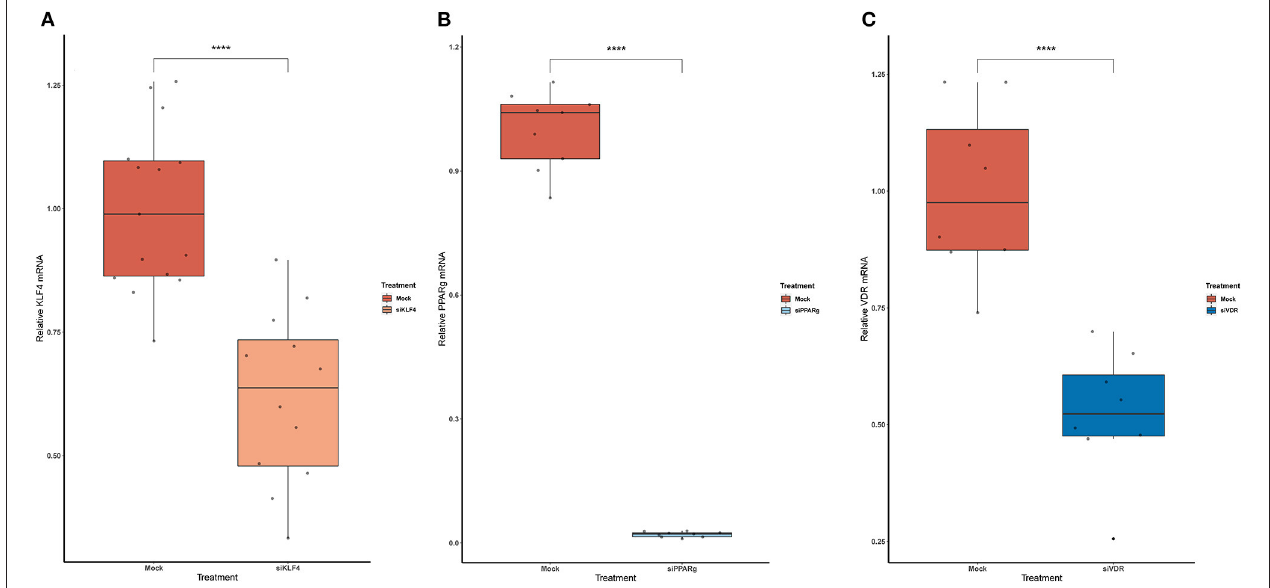
FIGURE 3 | Knock-Down efficiency for KLF4 (A) , PPARg (B) , and VDR (C) . Data are shown as box plots representing median ± quartiles ( n = 4). Dots represent technical replicates. A Student’s t -test was used for statistical analysis (**** p > 0.0001). PPARg, peroxisome proliferator-activated receptor g; KLF4, Krüppel-Like Factor 4; VDR, vitamin D